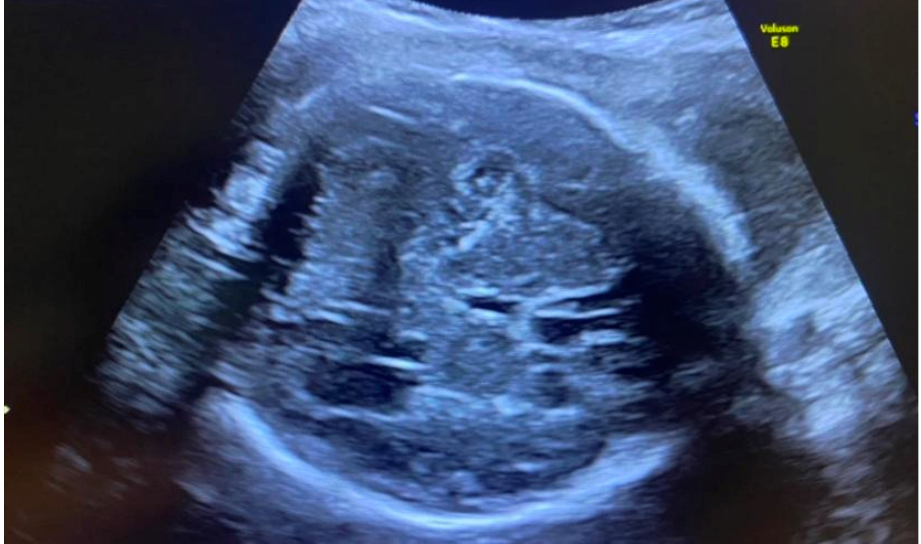
Figure 4. Intracranial calcifications; head circumference below the 3rd percentile—microcephaly.